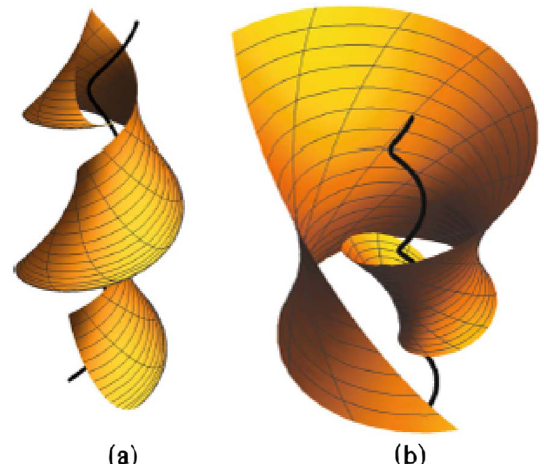
Figure 8. The spacelike circular surfaces with r = 1 and r ¼ s